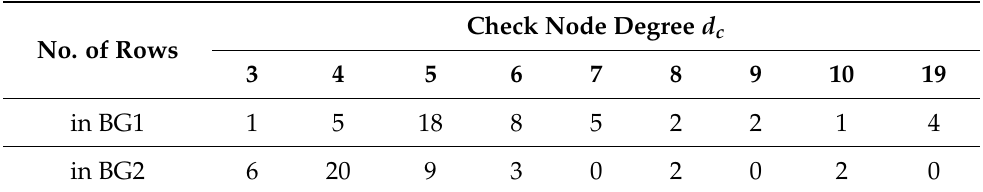
Table 3. Check node degree d c distribution for 5G NR LDPC